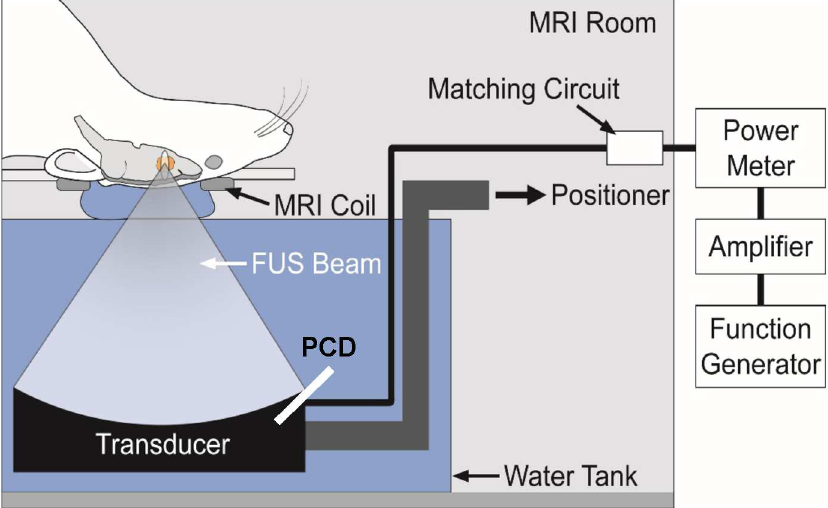
Fig 1. Schematic of the MRI-guided FUS systemused in this work. The function generator,amplifier, and power meter were located outsidethe MRI room. A passive cavitationdetector (PCD) was used to monitor the